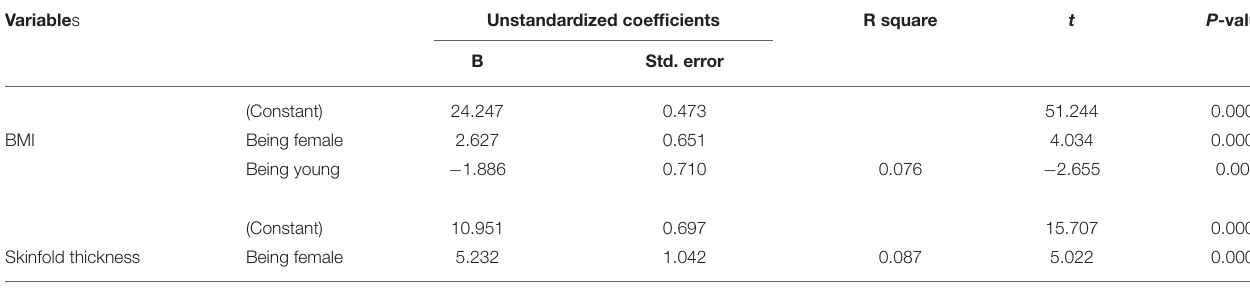
Skinfold thickness